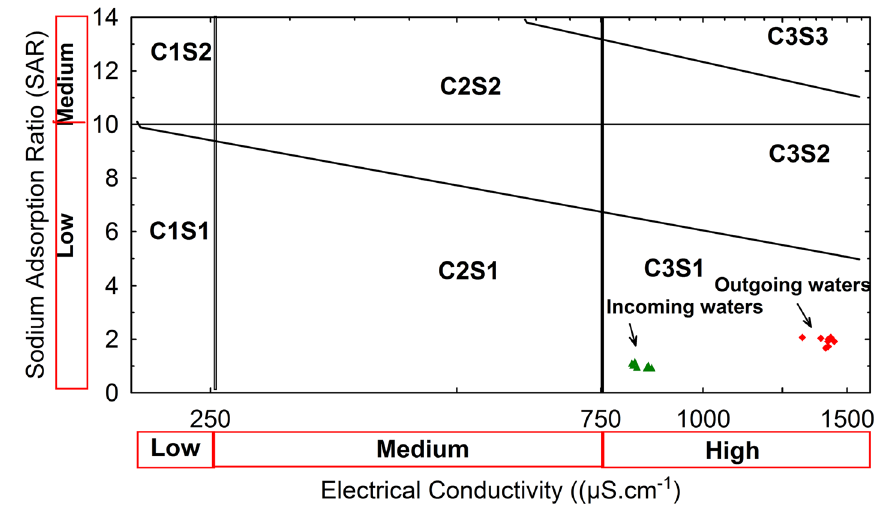
Fig. 7 Relationship between the Sodium Adsorption Ratio (SAR) and the electrical con- ductivity (EC) of the incoming and outgoing waters in the phar- maceutical plant from February 27 to June 17,